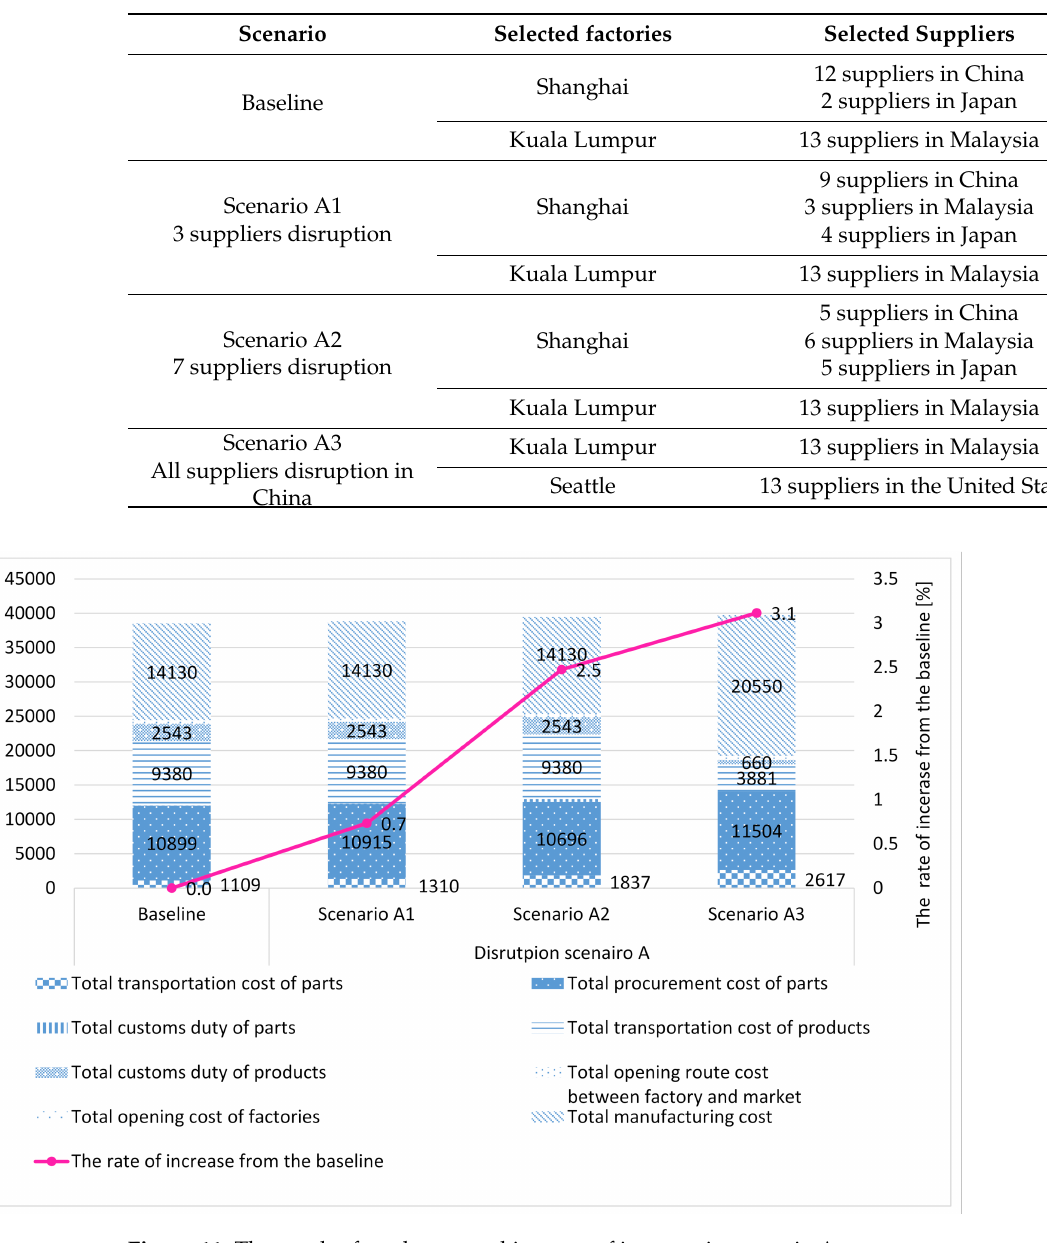
Figure 11. The result of total costs and its rates of increase in scenario